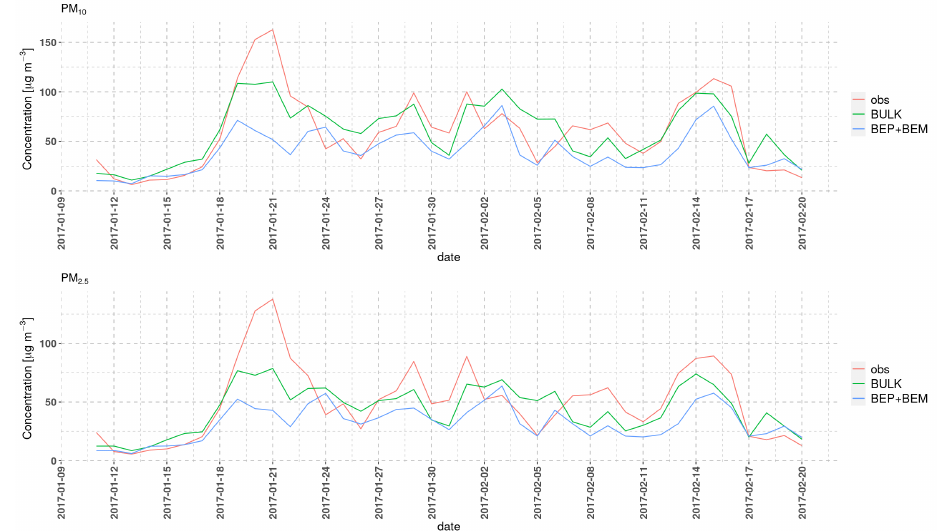
Figure 7. Average daily concentrations of PM 10 (top) and PM 2.5 (bottom) for observations (red) and the BULK (green) and BEP+BEM (blue) model configurations.